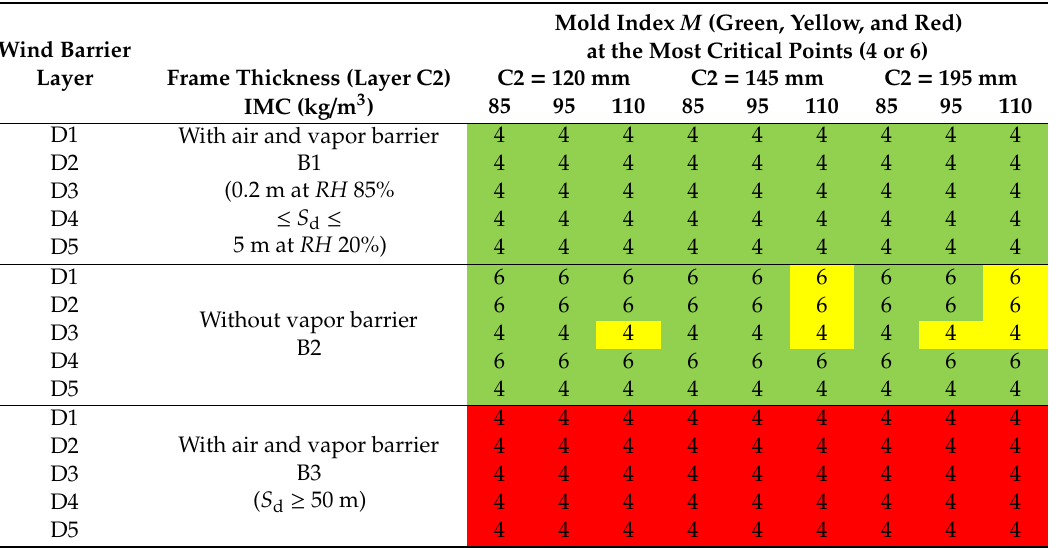
Table 6. Results of calculation of mold index M of wall constructions with CW. IMC of existing concrete description of layers D1 ...